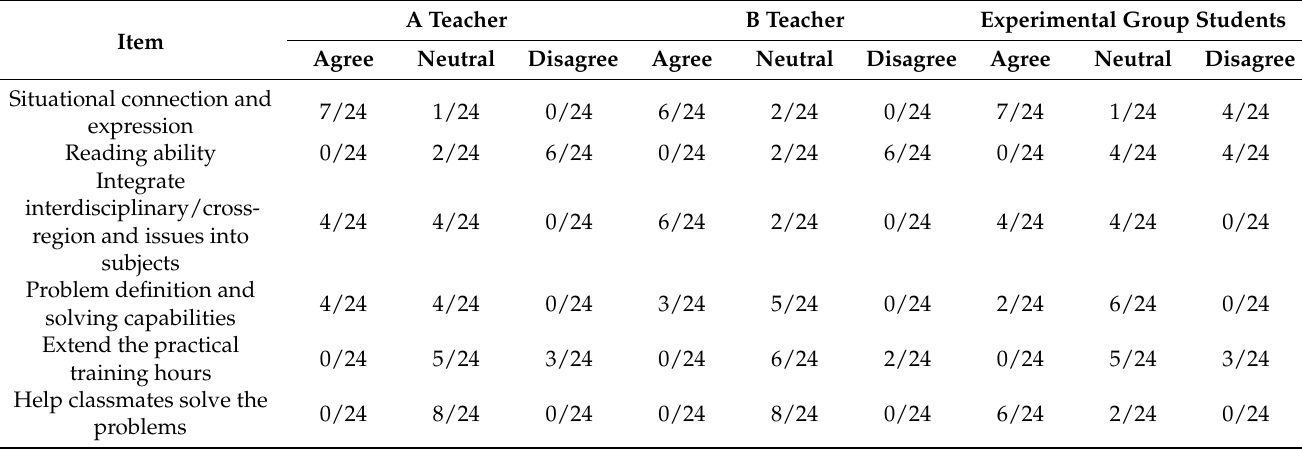
Table 22. Statistical table of a collection of organized, qualitative data including lots of feedback and common opinions that were gathered during competence-oriented instructional strategy implemen- tation.